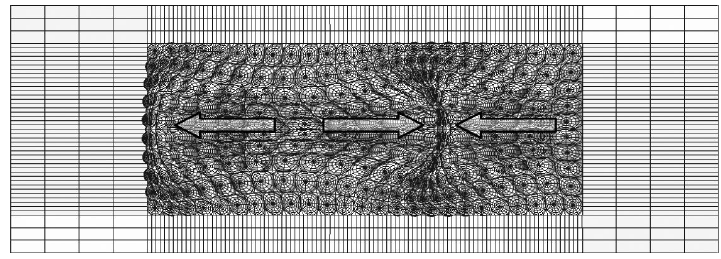
Fig. 50. EIDL 10th mode – 979 Hz – in plane triple opposite horizontal translation.